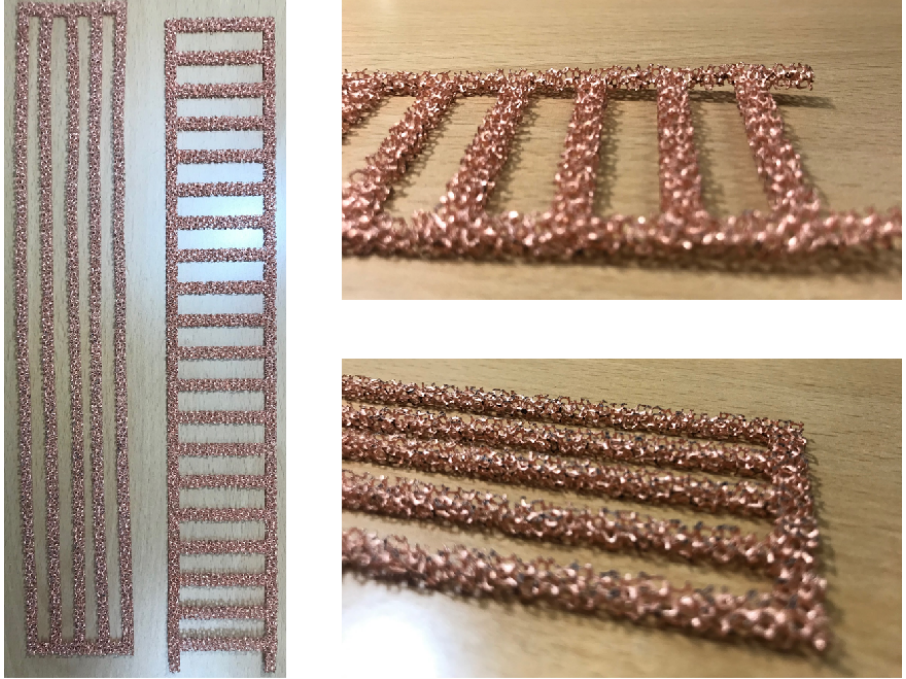
Figure 5. Images of the patterned models of the porous media.